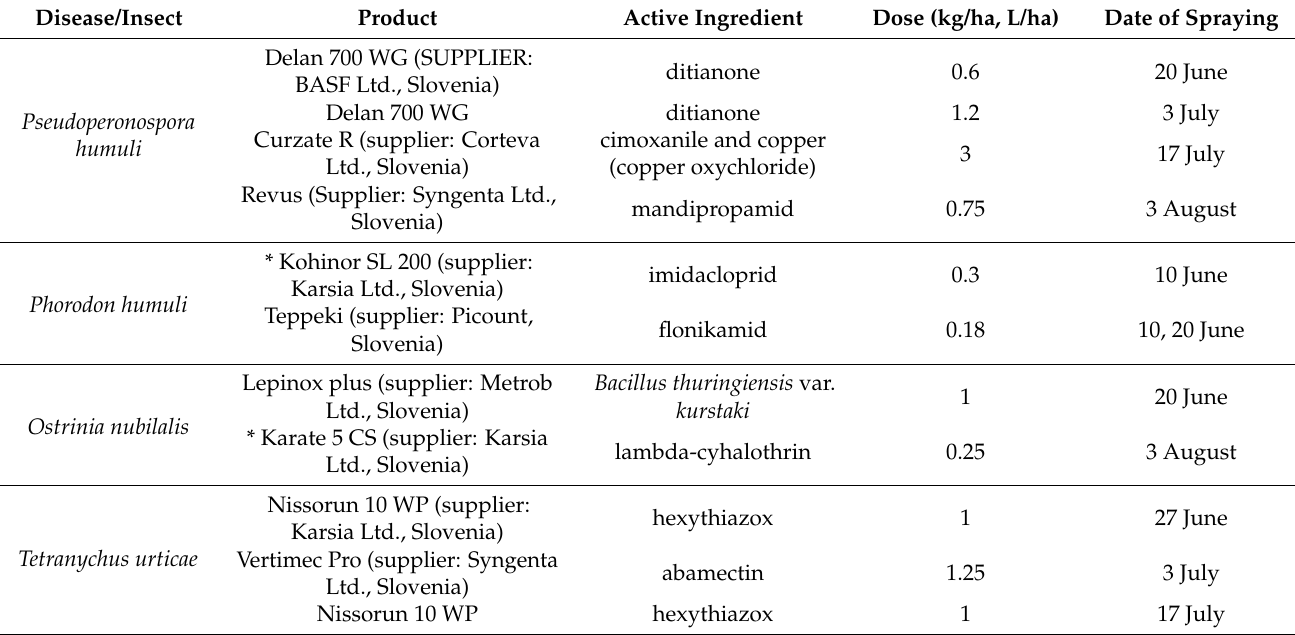
Table 2. List of insecticides, fungicides and acaricides used against the most important pests and diseases in hop plantations in 2015. Disease/Insect Product Active Ingredient Dose (kg/ha, L/ha) Date of Spraying